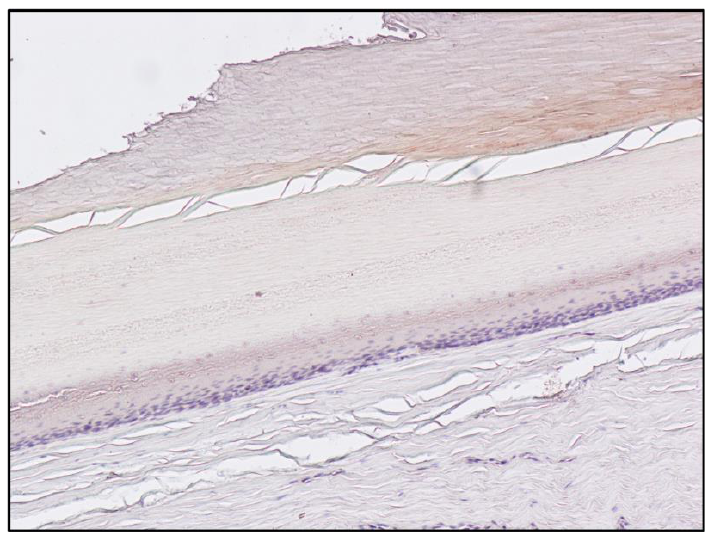
Figure 4. Immunoperoxidase staining for Sheep Anti-Morphine in the fingernail of Subject A, 10 × magnification. The immunohistochemistry protocol has been modified to observe the presence of any non-specific reaction; in this figure the primary antibody has not been used, while the secondary antibody conjugated to the peroxidase enzyme has been used.